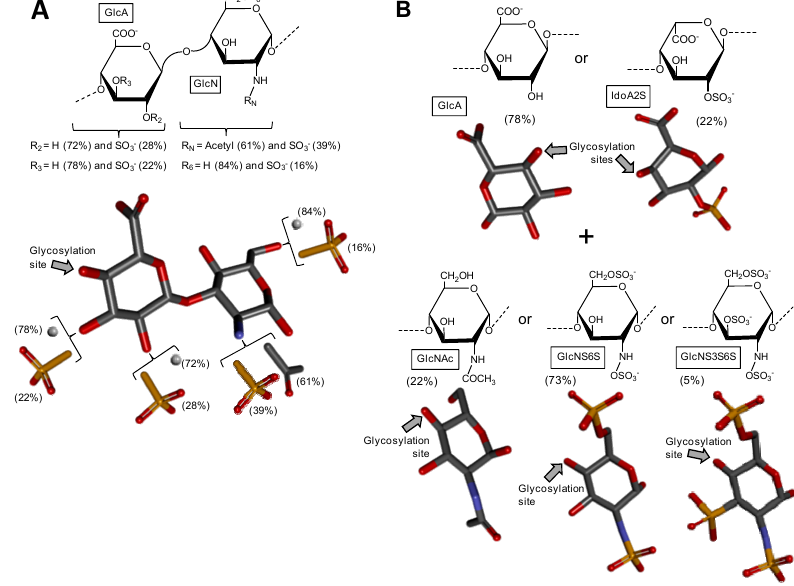
Figure 3. Haworth projections and stick model representations of the GAG structures from marine invertebrates. ( A ) Heparan sulfate from the bivalve Nodipecten nodosus composed of [GlcAR 2 R 3 -( β 1 → 4)-GlcNR N R 6 ] whose GlcN is β (1 → 4)-linked to the GlcA of the next disaccharide unit (disaccharide extracted from PDB ID 3E7J as model). R 2, R 3, R 6 can be either hydrogen or sulfate, and